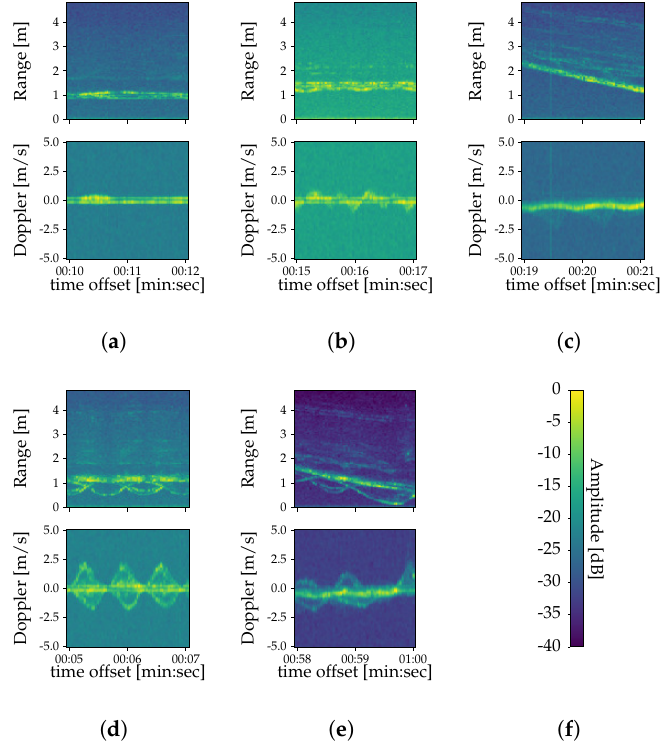
Figure 4. Exemplary range and Doppler spectrograms showing human activities ( a – e ) for configu- ration II. ( a ) Standing. ( b ) Waving. ( c ) Walking. ( d ) Boxing. ( e ) Boxing and walking. ( f ) Color bar showing amplitude levels in